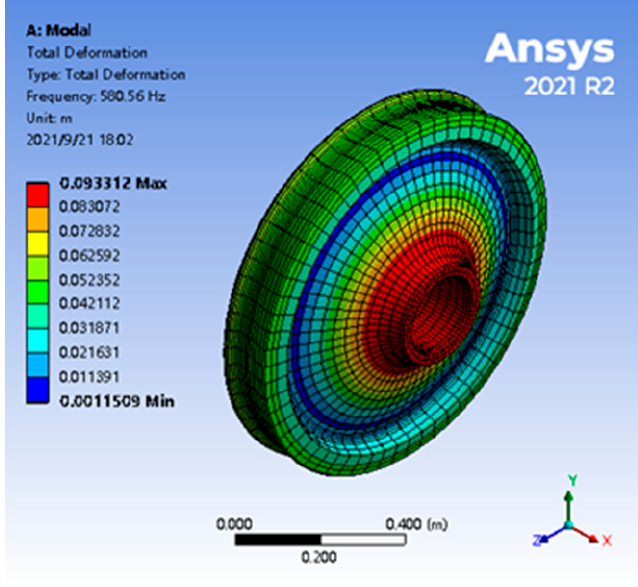
Figure 3. The ninth mode of the wheel mode.